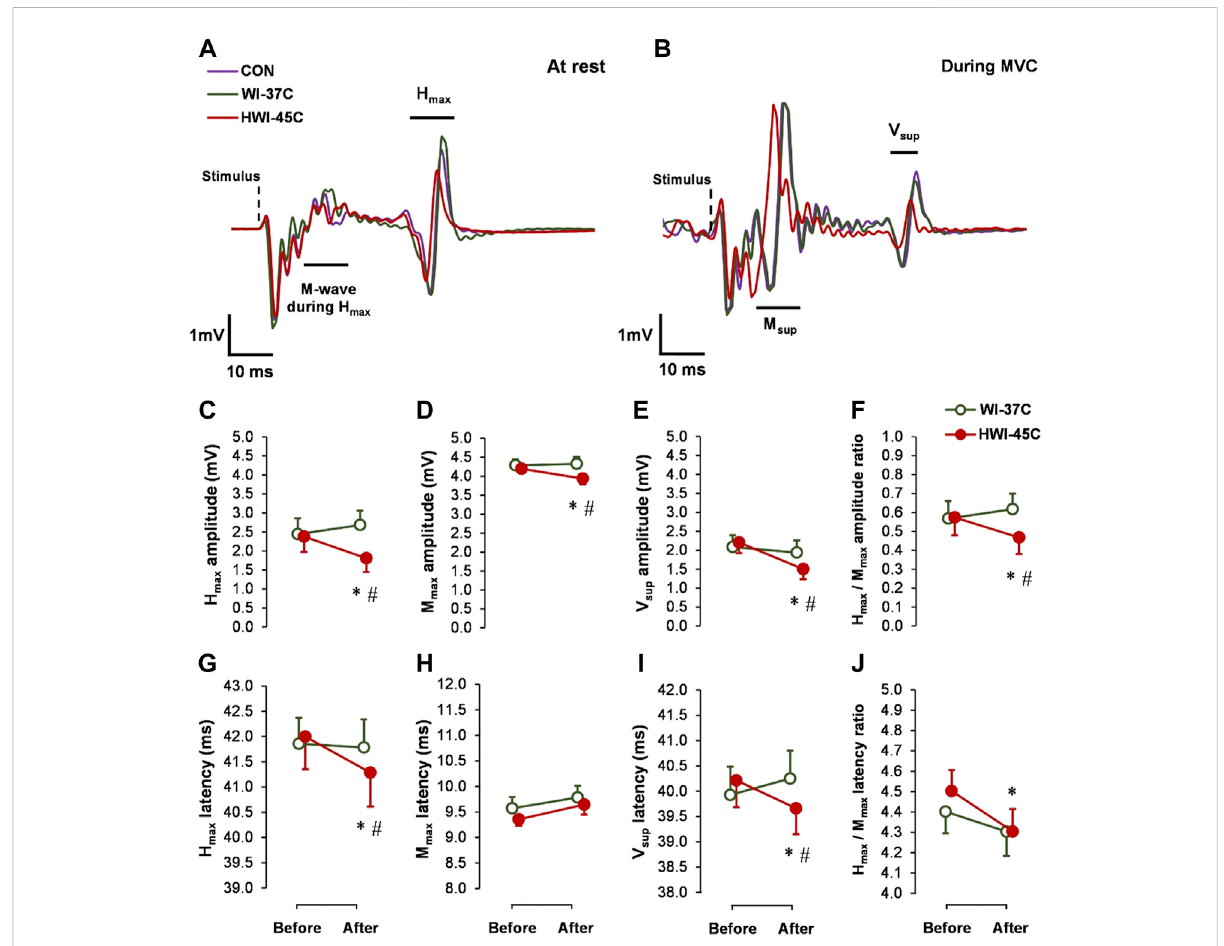
FIGURE 3 Examples of electrically induced waves recorded at rest (A) and during 5-s maximal voluntary contraction (MVC) (B) obtained in the control (CON) condition, and after whole-body immersion in water temperatures of 37 ° C (WI-37 ° C) and 45 ° C (HWI-45 ° C). Changes in re fl ex amplitudes of H max (C) , M max (D) , and V sup (E) , and the H max /M max amplitude ratio (F) , and changes in the re fl ex latency of H max (G) , M max (H) , and V sup (I) , and the H max /M max latency ratio (J) of the soleus muscle of the dominant (right) leg from before to after WI-37 ° C and HWI-45 ° C. * p < 0.05, HWI-45 ° C compared with before; # p < 0.05, HWI-45 ° C compared with WI-37 ° C. Values are expressed as mean and